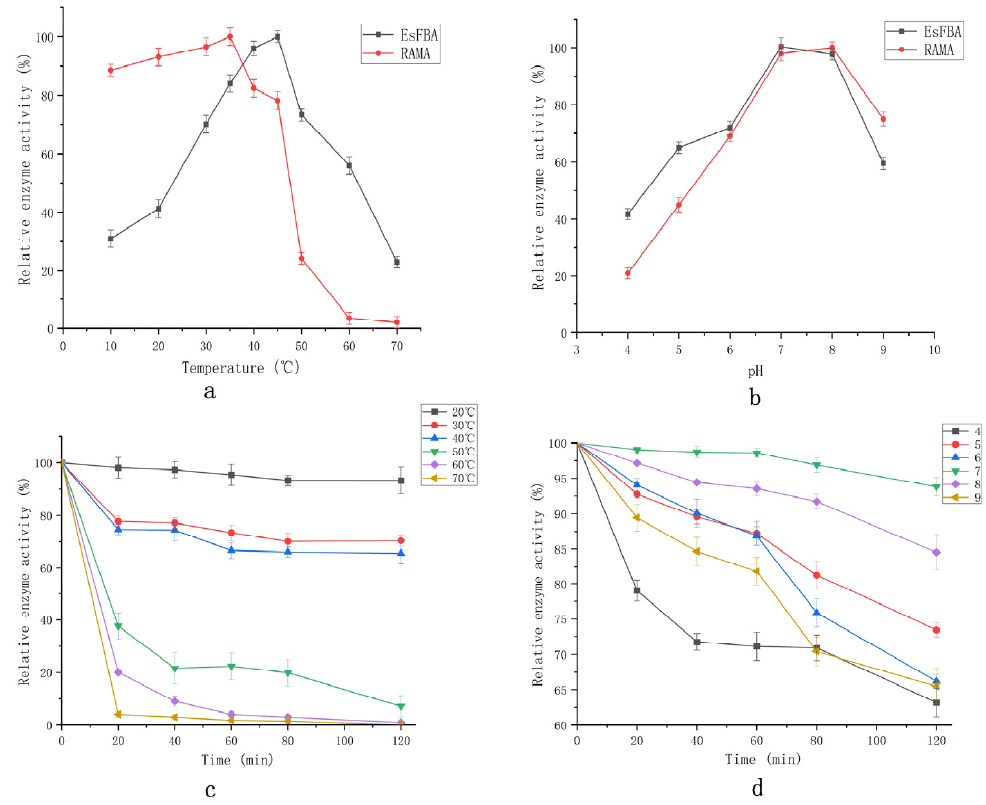
Figure 5. Characterization of recombinant EsFBA. ( a ) Optimum temperature, ( b ) optimum pH, ( c ) temperature stability, and ( d ) pH stability.